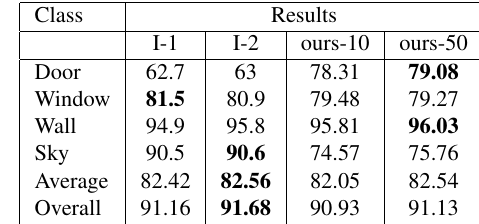
Table 2. Labeling results after optimization on dataset Graz.